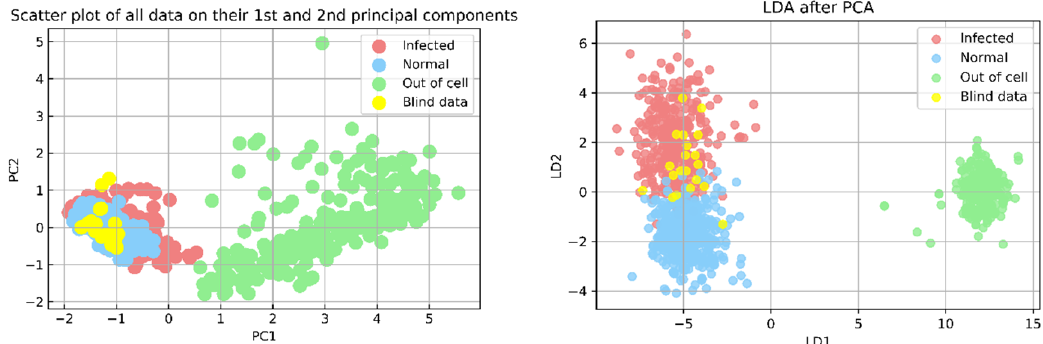
Figure 9. Transformation of blind data to PCA-LDA coordinates.